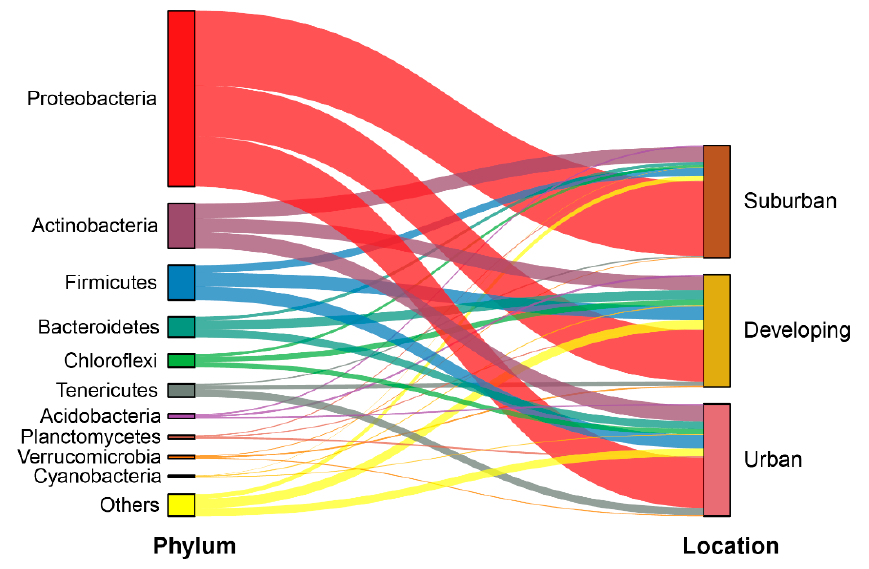
Figure 2. Relative abundance of top 10 phyla of the phyllosphere microbiota along the urbanization gradient. Only the top 10 species at the phylum taxonomic level are shown, and remainder of species are referred to as others. Suburban, developing, and urban stand for the corresponding urbanization level for sampling.